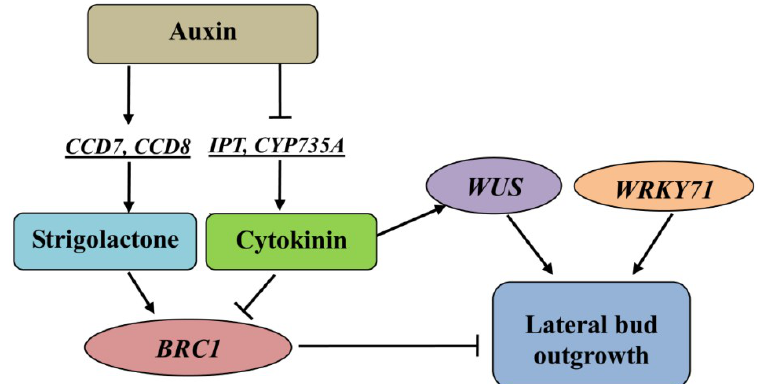
Figure 9. A hypothetical model to investigate the molecular mechanism of shoot branching in C. appendiculata . Auxin, cytokinin, and strigolactone might play crucial roles in regulating lateral bud outgrowth. BRC1 acts as the integrator of these three hormones. Promotion and inhibition regulatory actions are indicated by arrows and lines with bars, respectively.